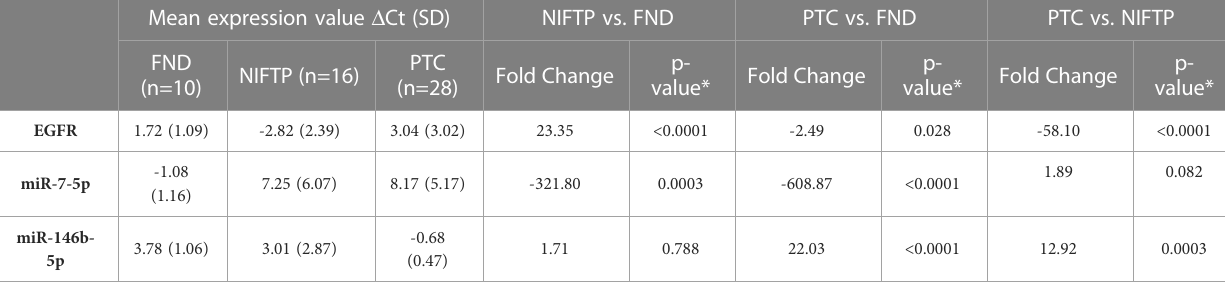
TABLE 1 Expression of EGFR, miR-7-5p and miR-146b-5p in thyroid tissue samples. Mean expression value D Ct (SD)